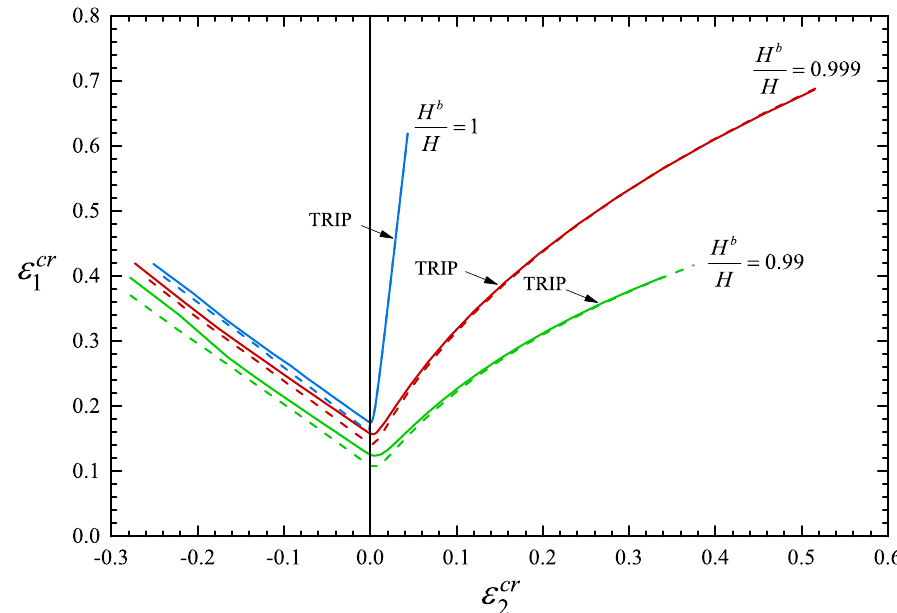
Figure 19. Forming limit curves for two different values of initial thickness inhomogeneities H b / H = 0.999 and H b / H = 0.99. The solid lines correspond to the TRIP steel, whereas the dashed lines are for a non-transforming